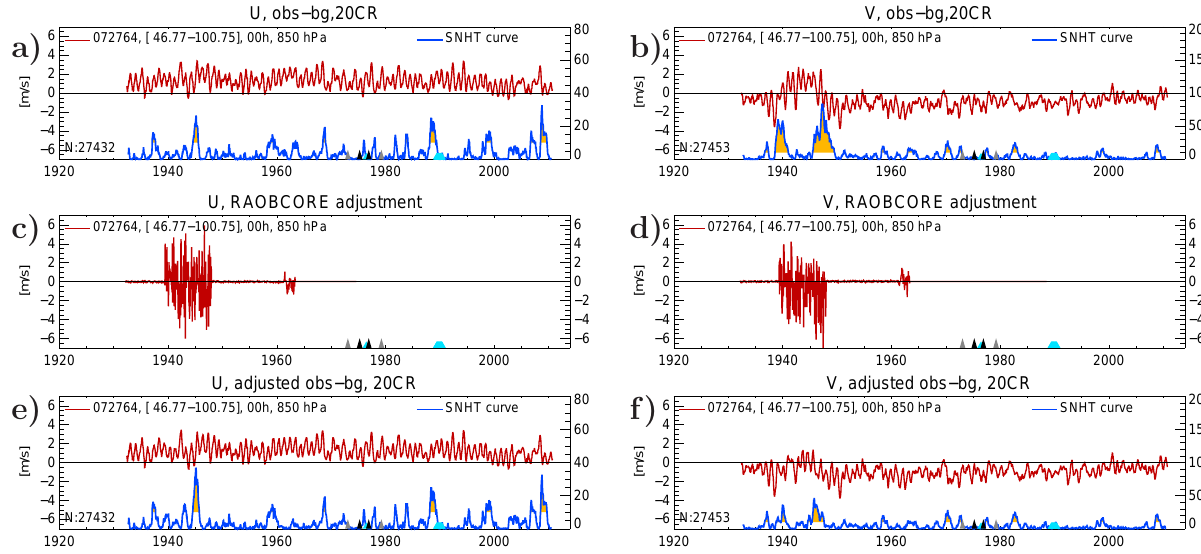
Figure 8. (a) U and (b) V wind innovations , (c, d) wind adjustments and (e, f) adjusted innovations at the 850hPa level. Note that a positive Figure 8: a) U and b) V wind innovations , c,d) wind adjustments and e,f) adjusted inno- adjustment of wind direction as shown in Fig. 6c translates to negative V adjustments, depending on the strength of the predominantly vations at the 850 hPa level. Note that a positive adjustment of wind direction as shown in westerly winds. Fig. 6-c) translates to negative V adjustments depending on the strength of the predomi- nantly westerly winds.